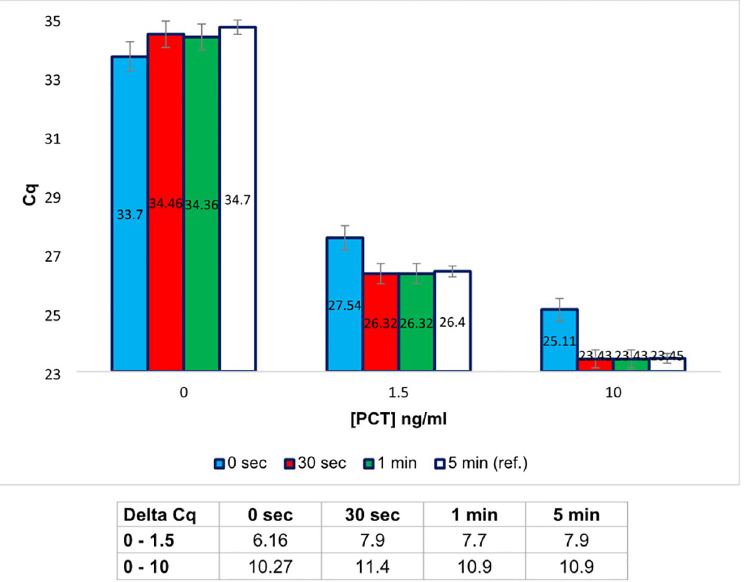
Fig 4. PEA performed for different durations of incubation after the dilution step, for three concentrations of rPCT. The incubation time after dilution of the binding product was progressively decreased from 5 min (reference test, ref.) down to 30 sec. The results, given in Cq values, correspond to the mean of a minimum of three duplicate experiments. The data are also expressed in Delta-Cq (Table below the histograms) corresponding to the difference between the Cq value obtained for 0 ng/mL of rPCT and the Cq value obtained for different concentrations of rPCT.